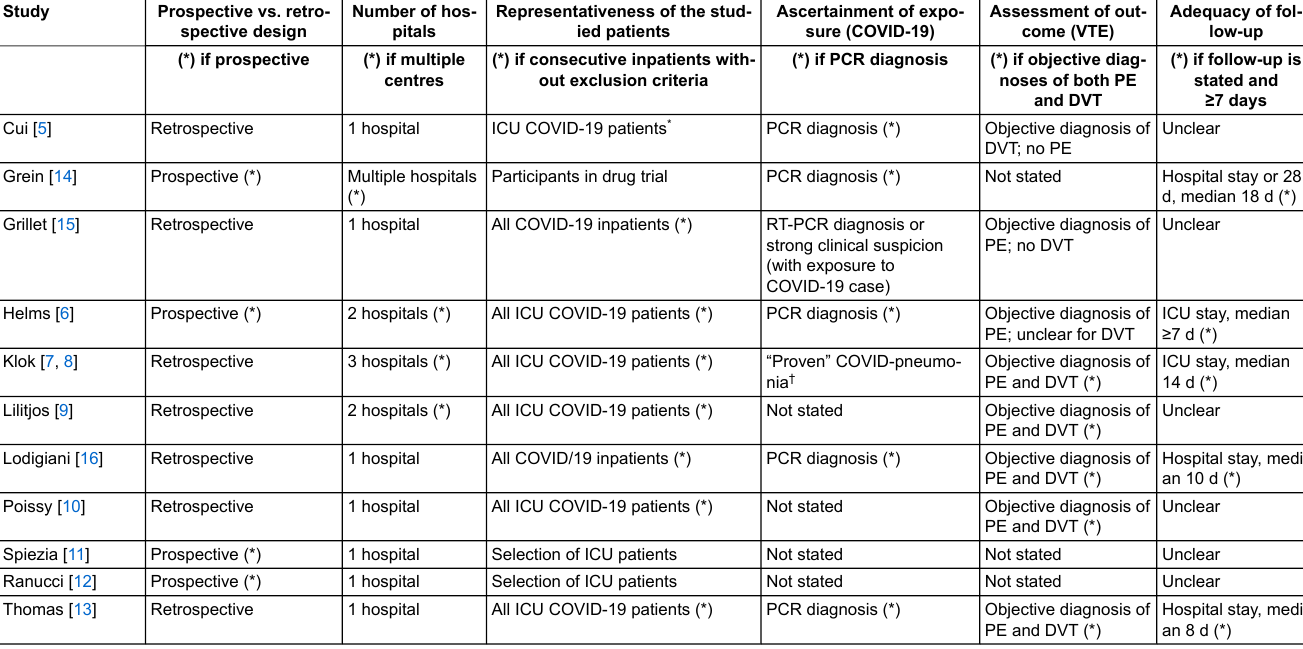
Table 2: Quality assessment of the studies. Study Prospective vs. retro- spective design